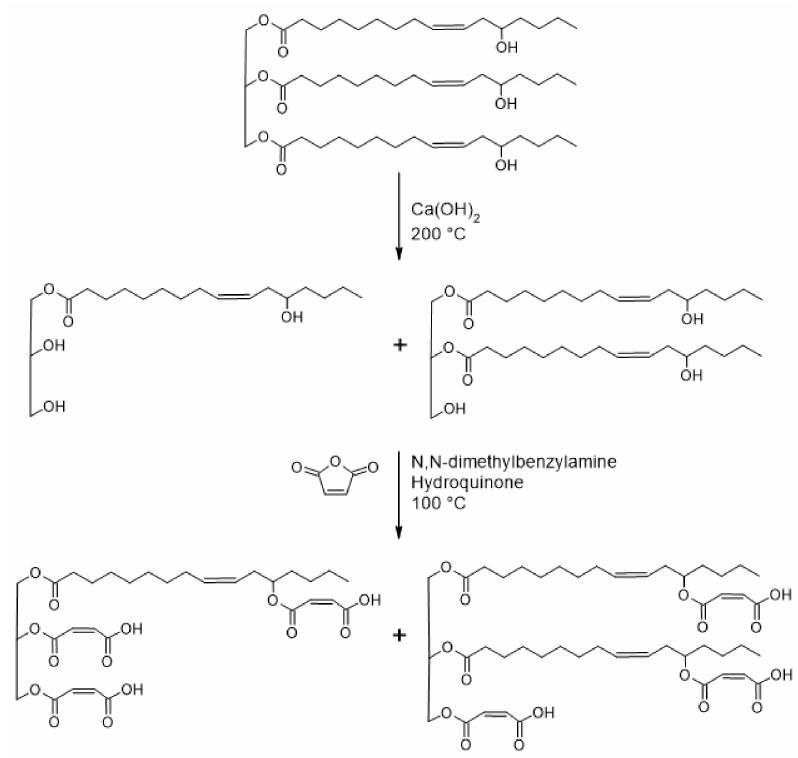
Figure 1. Schematic presentation for the synthesis of